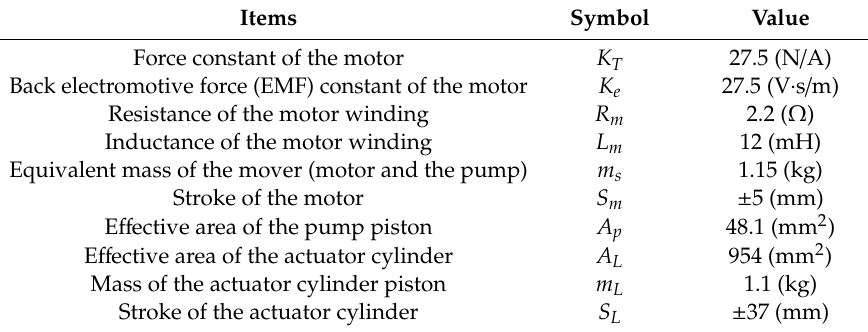
Table 2. Key design parameters of the actuator.